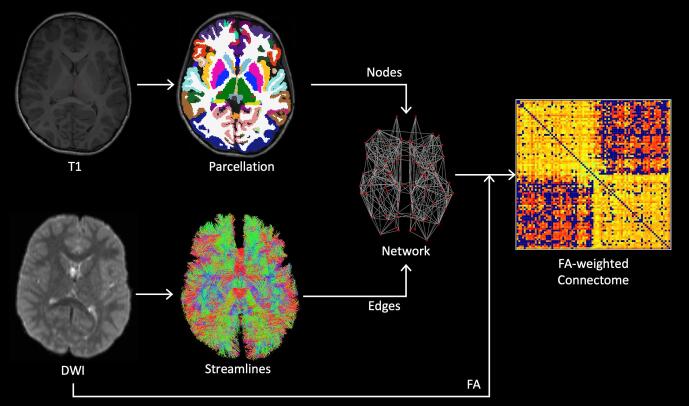
Processing pipeline. Method for constructing structural brain networks from T1 and DWI data. Cortical and sub-cortical nodes were defined by segmentation of the T1-weighted structural scan. Edges were determined by seeding streamlines from the cortical grey/white matter interface and performing tractography using the fibre orientation distribution obtained by spherical deconvolution of the measured diffusion signal. Edges were weighted by the mean FA along all streamlines passing between the corresponding pair of nodes, and the resulting network was represented by a connectivity matrix.